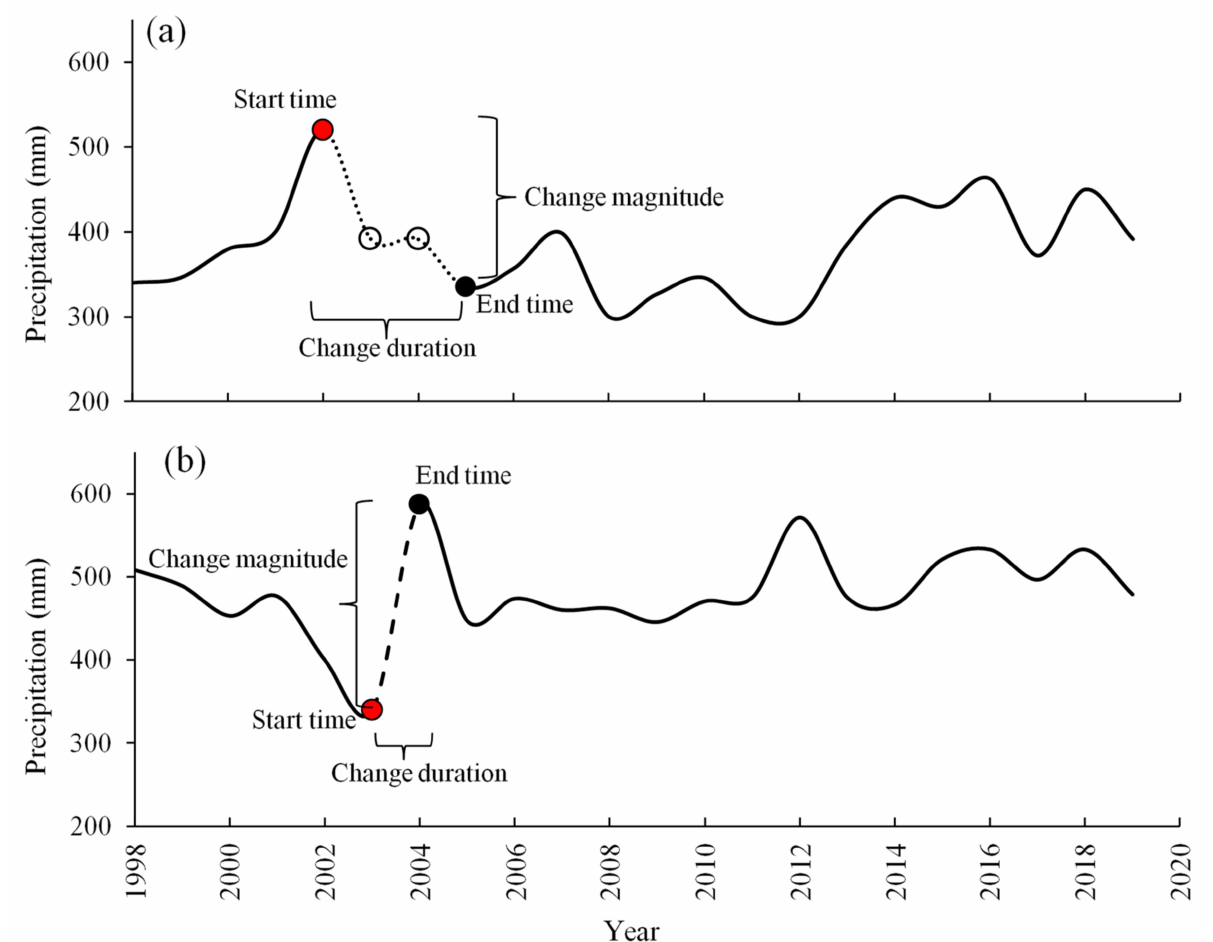
Figure 4. An example of a typical ( a ) non-abrupt breakpoint with a three-year change duration and − 180 mm change magnitude and ( b ) abrupt breakpoint with a one-year change duration and +247 mm change magnitude in the global precipitation time